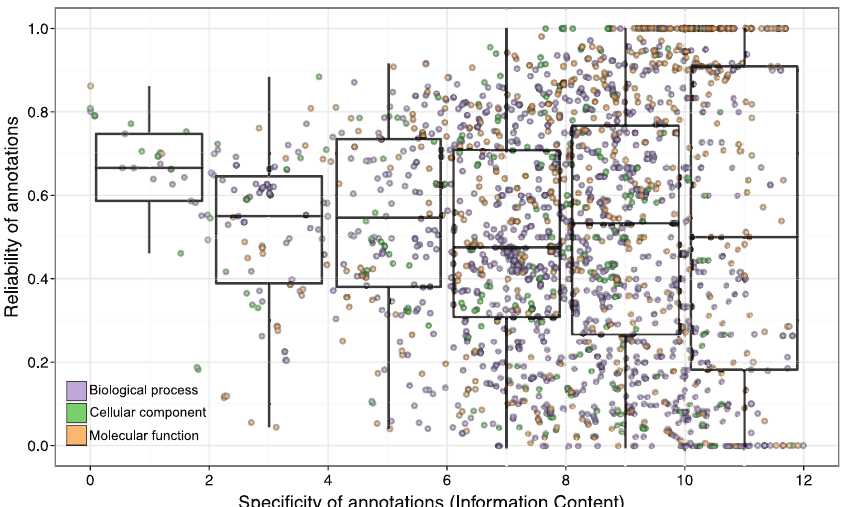
Figure 4. Reliability of electronic annotations in the 16-01-2008 UniProt-GOA release compared to the specificity of the assigned GO term—Information Content in the 16-01-2008 UniProt-GOA release. Each point represents one GO term, and its color corresponds to the ontology in the legend. Each boxplot summarizes the reliability of a selection of GO terms: those with specificity in the range denoted by the width of the boxplot. Lower, mid, and upper horizontal lines denote the first quartile, median and the third quartile, respectively. Vertical lines reach the 1.5 interquartile ranges from the respective quartiles or reach the extreme value, whichever is closer. To be visualized in these plots, a GO term needs to have assigned at least 10 electronic annotations in the 16-01-2008 UniProt-GOA release and at least 10 experimental annotations in the 11- 01-2011 UniProt-GOA release.